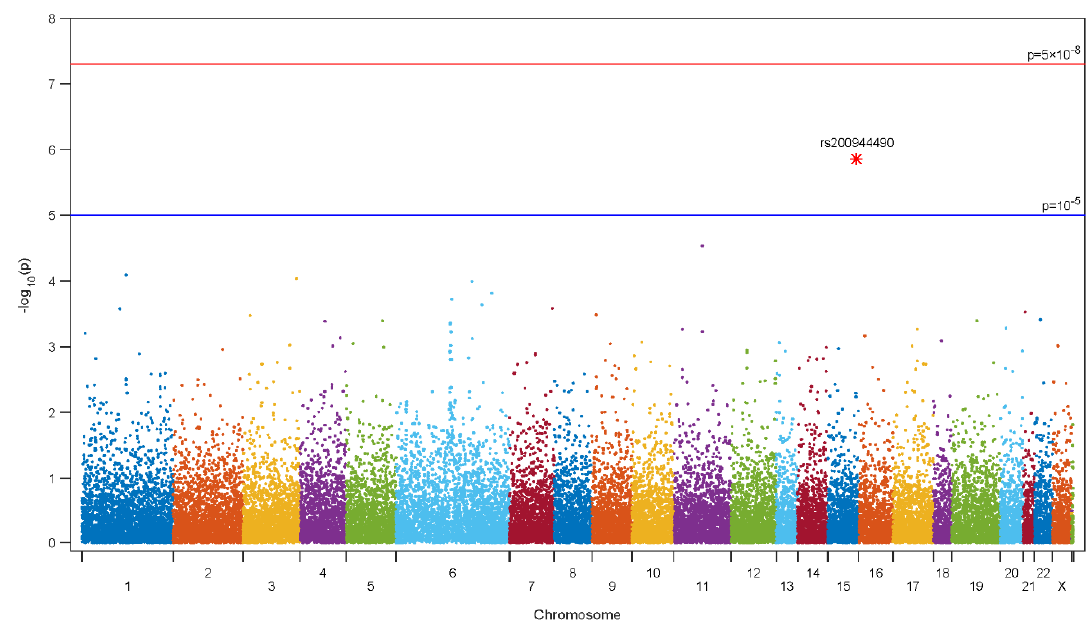
Figure 1. Manhattan plot. Manhattan plot of the association between high Gleason score after radical prostatectomy and 242,186 single nucleotide polymorphisms identified in patients with prostate cancer via a custom HumanExome BeadChip v1.0 (Illumina Inc. San Diego, CA, USA) (A color version of the figure is available Table 2. Logistic regression analysis of exome array to predict pathological Gleason core ≥8 after radical prostatectomy. SNPID Chr